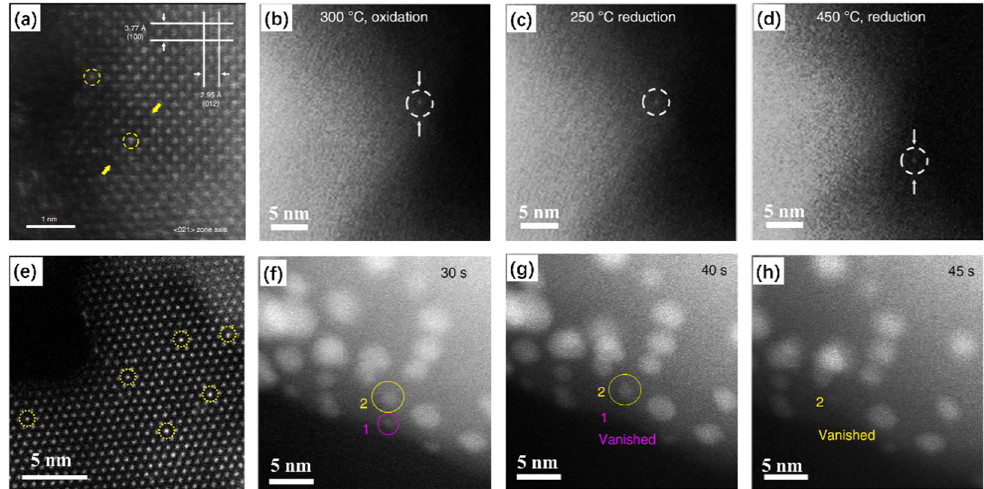
Figure 4. ( a – d ) In situ AC-STEM characterization of atomically dispersed Pt catalysts during sequential exposure conditions [77]. ( a ) HAADF image of Pt iso / TiO 2 < 021 > zone axis. The HAADF images of Pt iso / TiO 2 at ( b ) 300 ◦ C, 760 Torr of O 2 for 30 min, ( c ) 250 ◦ C, 760 torr of 5% H 2 + Ar for 30 min, and ( d ) 450 ◦ C, 760 torr of 5% H 2 + Ar for 30 min. The yellow circles in ( b ), ( c ), and ( d ) identify the same Pt single atom. Reproduced with permission from [77], Nature Publishing Group, 2019. ( e – h ) In situ characterization of Pt / Fe 2 O 3 NP oxidative dispersion [78]. ( e ) HAADF image of . ( f ) HAADF-STEM image of Pt / Fe 2 O 3 NP being calcinated at 800 ◦ C under 1 bar flowing O 2 for 30 s, ( g ) 40 s, and ( h ) 45 s. Reproduced with the permission from Ref. [78], Nature Publishing Group, 2019.